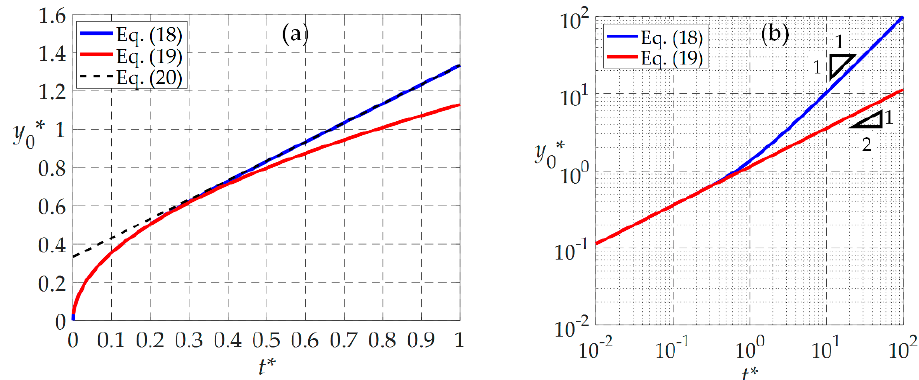
Figure 5. Shoreline evolution at the river mouth with ( a ) normal plot and ( b ) log-log plot to show the difference of power to the dimensionless time.